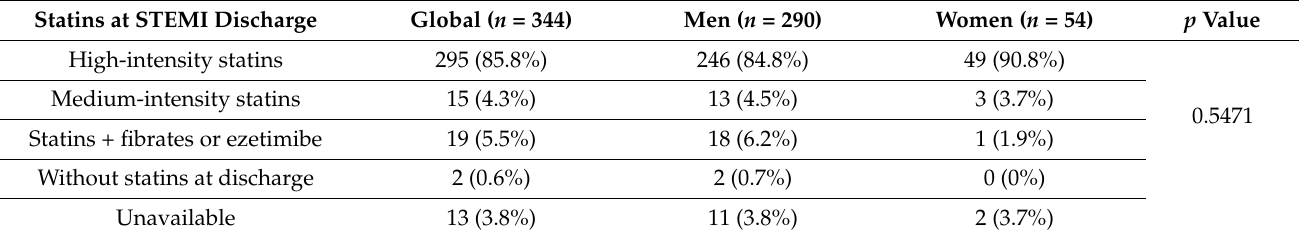
Table 3. Statins treatment at discharge from STEMI